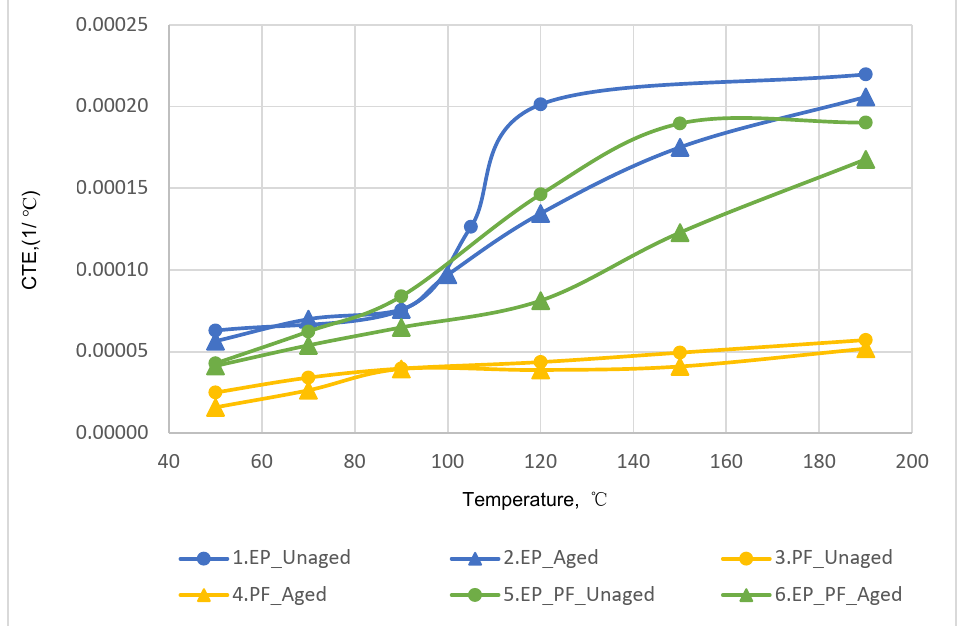
Figure 14. Temperature dependence curves for unreinforced binders based on dilatometry results: (1) epoxy binder without temperature aging; (2) epoxy binder after temperature aging; (3) phenolic binder without temperature aging; (4) phenolic binder after temperature aging; (5) epoxy-phenolic binder without temperature aging; (6) epoxy-phenolic binder after temperature aging.